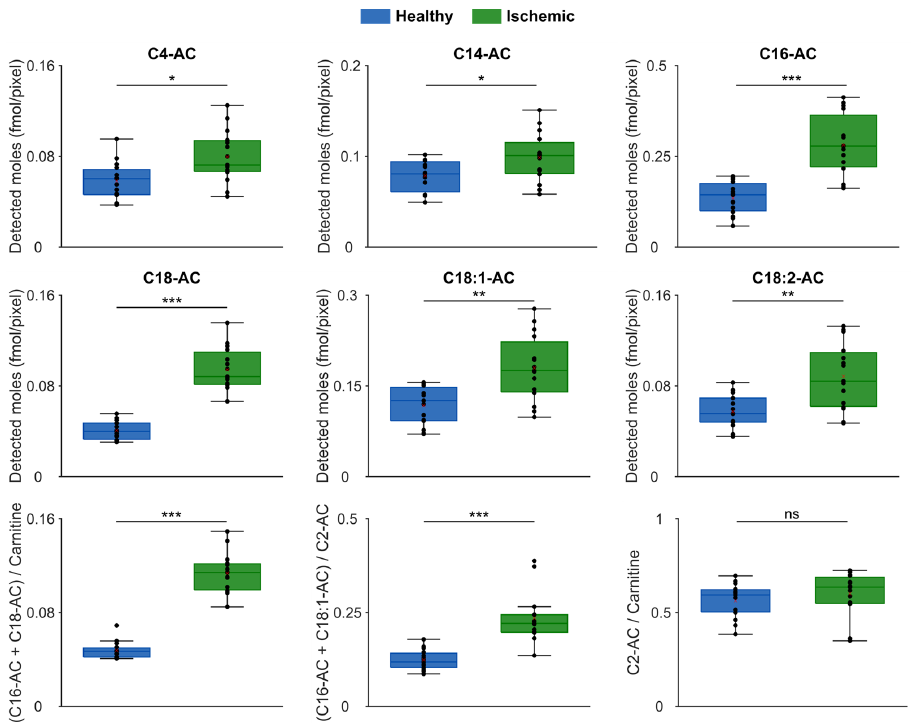
Figure 4. Accumulation of ACs and enzymatic activity. ROI analysis of significantly altered ACs that accumulated in the ischemic region (top two rows) and ratios of (C16 ‐ AC + C18 ‐ AC)/carnitine depicting CPT1 activity, (C16 ‐ AC + C18:1 ‐ AC)/C2 ‐ AC depicting CPT2 activity and C2 ‐ AC/carnitine depicting β‐ oxidation activity (bottom row). Statistical significance was assessed using a two ‐ tailed Wilcoxon rank sum test where significant differences (* p < 0.05, ** p < 0.01, *** p < 0.001) are denoted with asterisk(s).